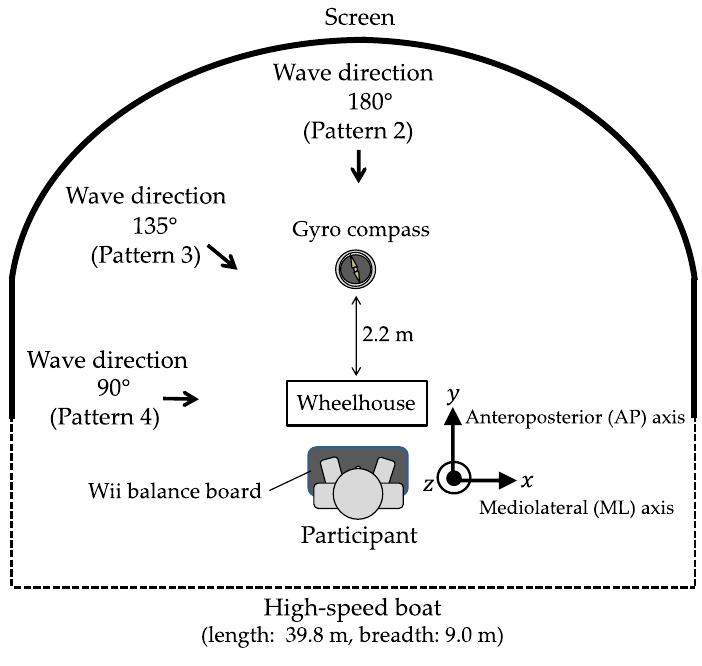
Figure 3. Wave directions with respect to the participant’s position.